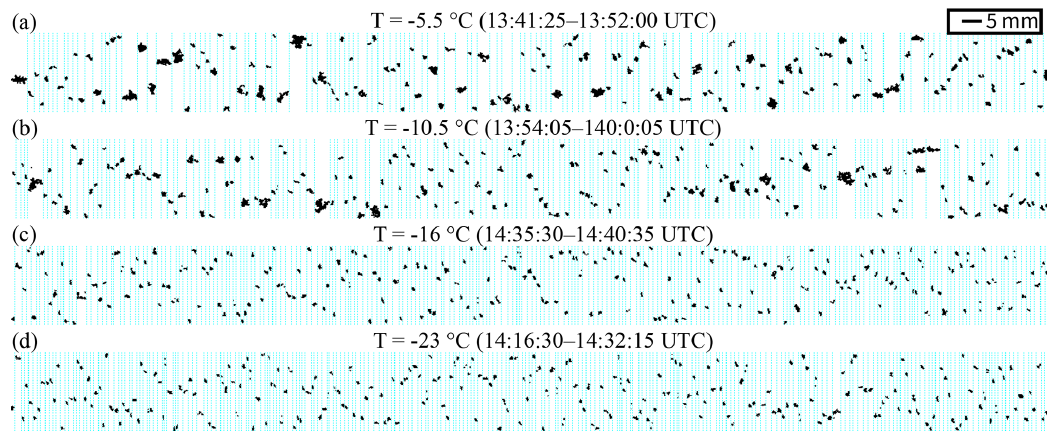
Figure 14. Same as in Fig. 10, but for the 20 May 2011 case.